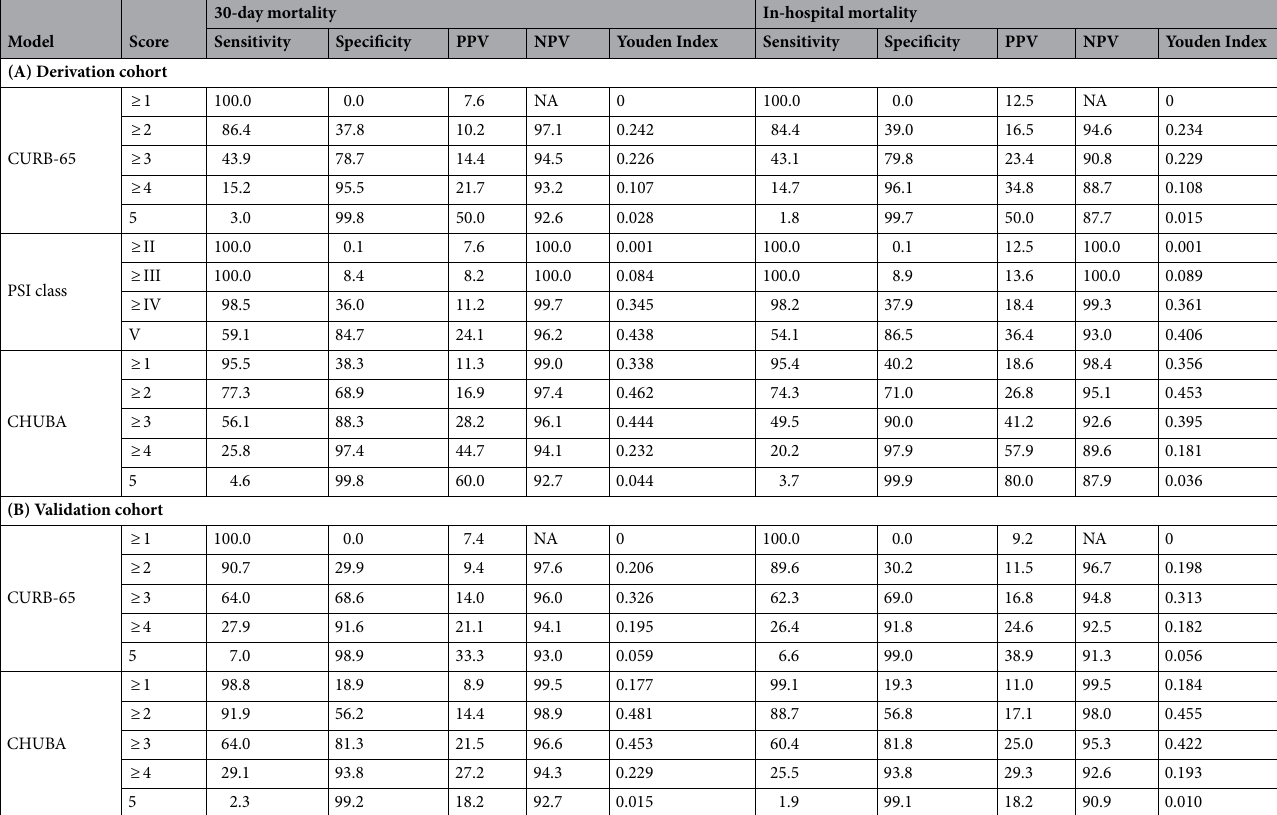
Table 5. Operating characteristics of different prediction rules for 30-day and in-hospital mortality. Data are presented as percentage or n. CURB-65, confusion, urea, respiratory rate, blood pressure, age ≥ 65;